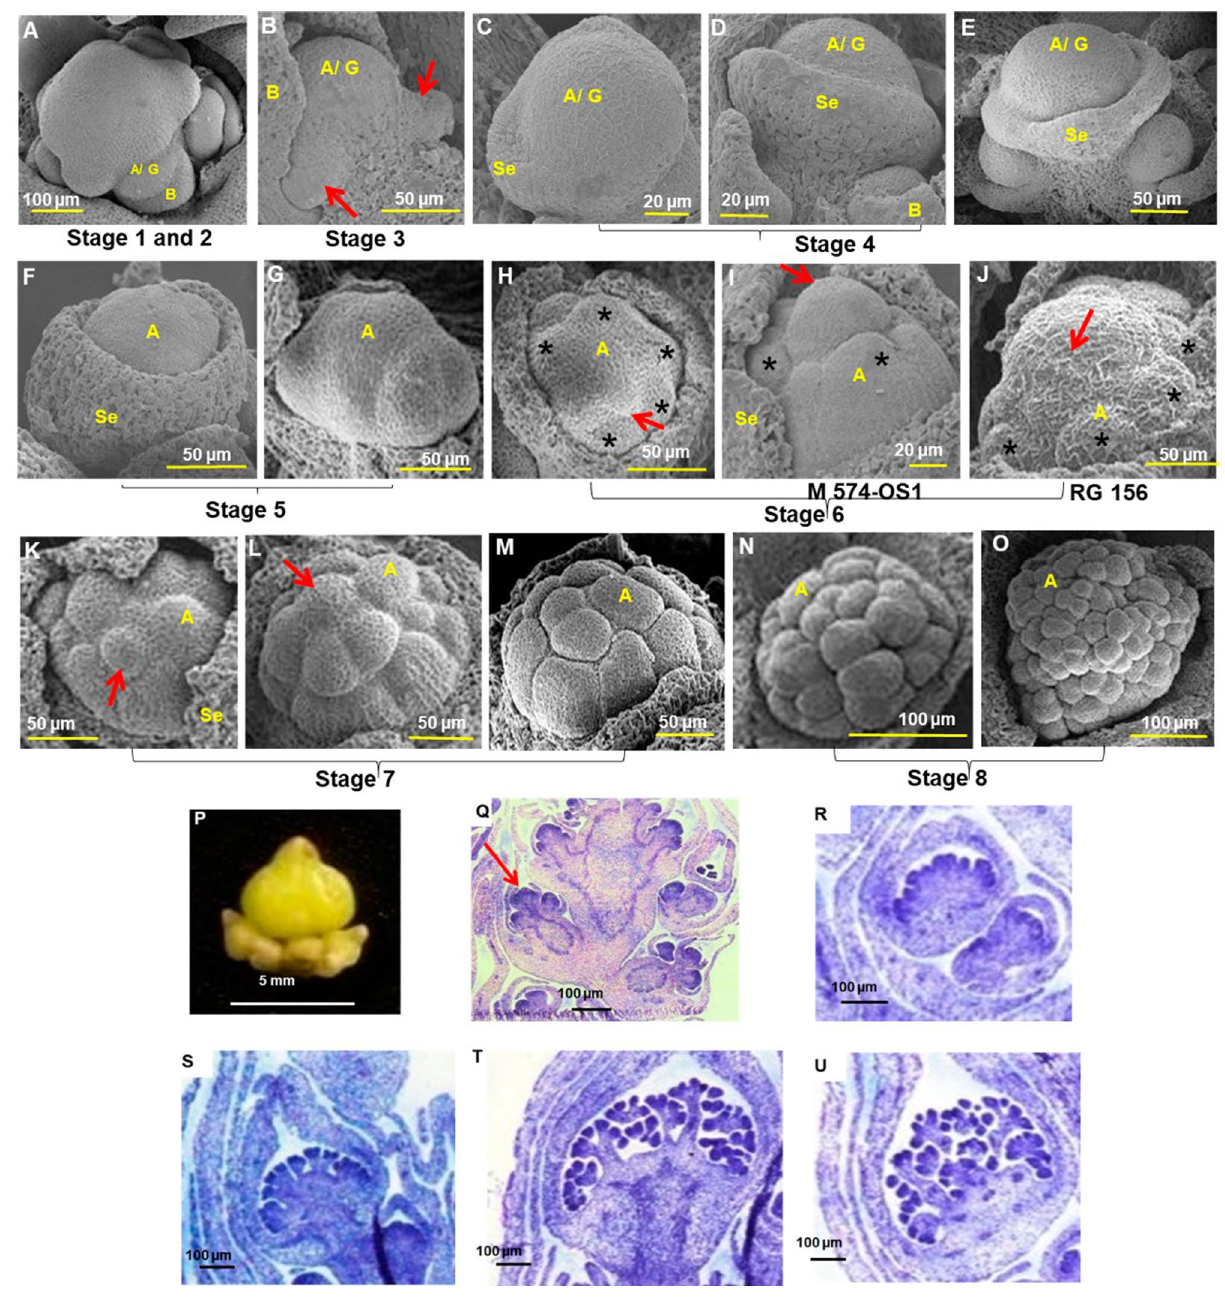
Figure 4. Stages of male flower development. ( A ) Bract (stage 1) and floral primordia (stage 2) initiation. ( B ). Division in central floral primordia (stage 3). Arrows indicate lateral floral primordia. ( C–E ) Sepal primordia initiation (stage 4). ( F,G ) stage 5 with ( F ) cup shaped flower bud and ( G ) irregular floral meristem. ( H–J ) Stage 6 with 6–7 celled structure in ( I ) M574-OS1 ( J ) RG 156. Arrow indicates central cell and asterisk the peripheral cells. ( K–M ) Growth arrest of pistil primordium (stage 7). ( N,O ) Stamen development (stage 8). ( P ) Male flowers in triplets. ( Q–U ) Histological sections showing development of male flower bud (×40 magnification). Scale bars are shown below. A androecium, B bract, G gynoecium, Se sepal rudimentary stamens, at most developmental stages from stages 6 to 12 (Fig. 6M–Q). The aborted stamen primordia, which remained dormant as a layer of cells beneath the ovary (Fig. 6R,S), resumed development as small protrusions or bulges at the base of the ovary during reversion (Fig. 6T), to result in rudimentary stamens. Such reversions occurred even after complete pistil development, but simultaneous development of gynoecium and androecium were not observed in reverted female flowers. When reversion occurred during later stages of female flower development (after complete development of gynoecium), rudimentary stamens appeared without complete development, with less branching and development which was limited to filament bifurcation (Fig. 6U,V). Also, anthers in reverted stamens of bisexual flowers of DPC 9-OS2 were larger in size